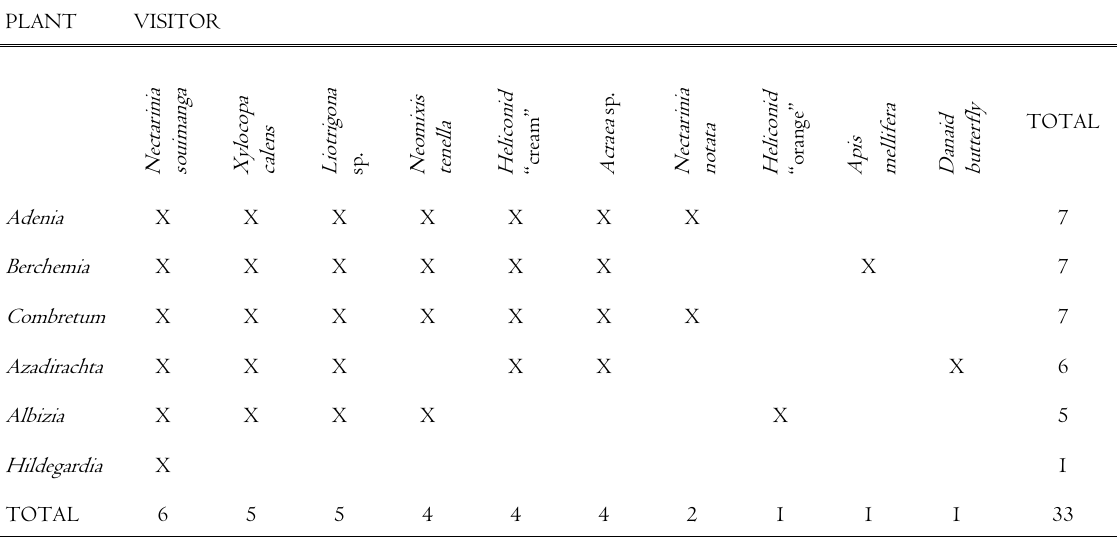
TABLE 2. The partial qualitative flower visitation web for Kirindy forest at the end of the dry season, 2009. Nectarinia are sunbirds, Neomixis is the common jery, Xylocopa a carpenter bee, Liotrigona a stingless bee (see Brooks and Michener 1988), Apis the honey bee, and the remainder are butterflies. The Acraea sp. has clear outer forewing and orange inner wings with black patches; the Danaid butterfly is likely Danaus chrysippus . Small insects that could not be identified more precisely were ignored of necessity, as we had no way to match them across plant species. The canopy tree Hildegardia erythrosiphon (Malvaceae) appears in the plant column, as visitor-based sampling detected visits by souimanga